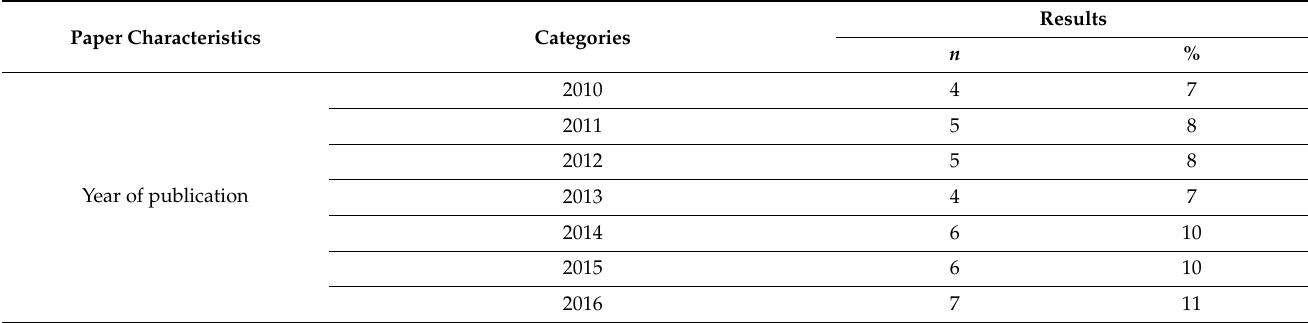
Table 3. Main characteristics of the included